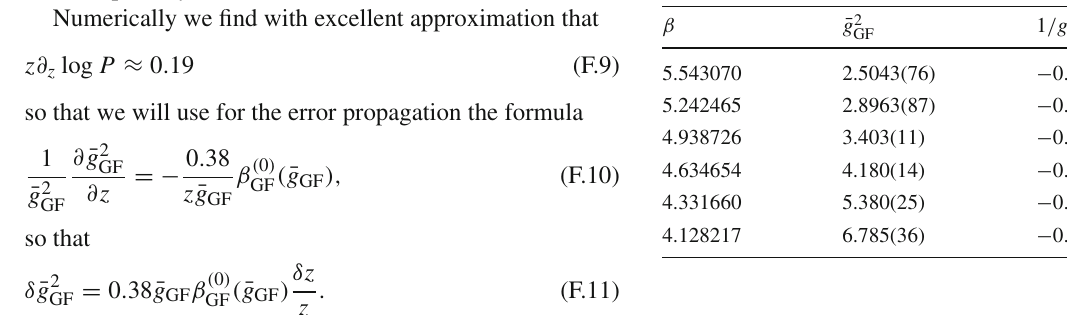
Table 14 Simulations with L / a = 24 used to interpolate the value ¯ g